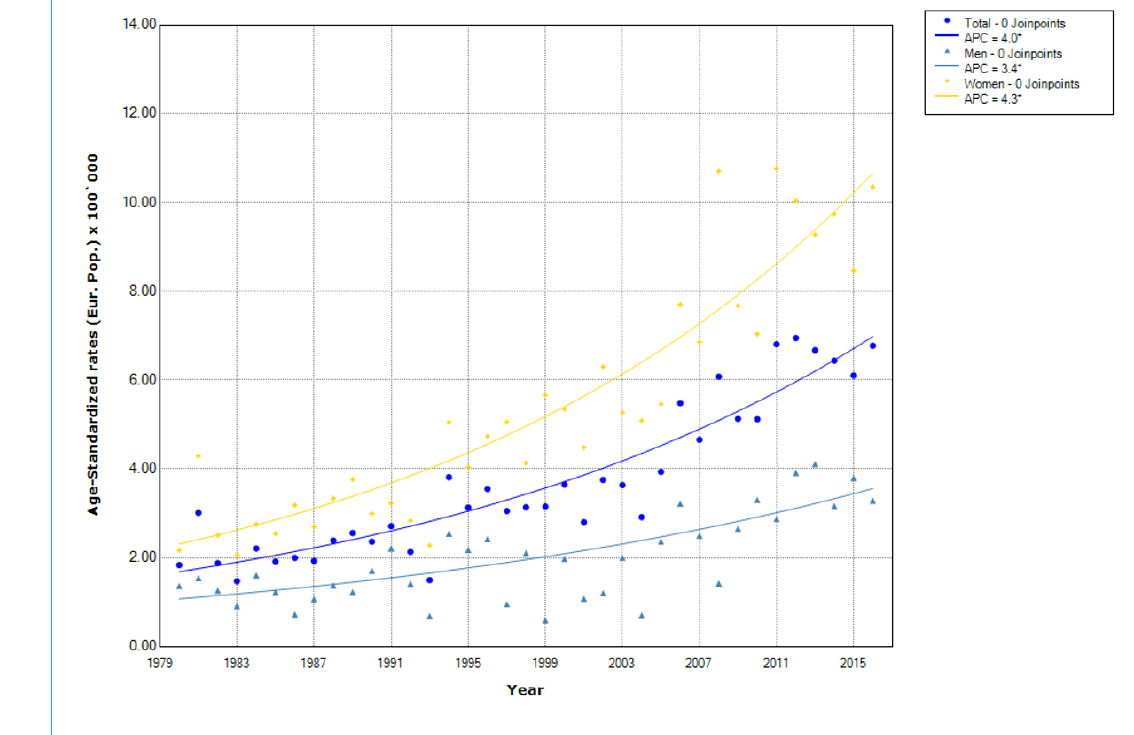
Figure 1: Trends in papillary thyroid cancer incidence overall and by sex. Canton of Zurich 1980–2016. APC (annual percentage change). Age-standardised rates (European